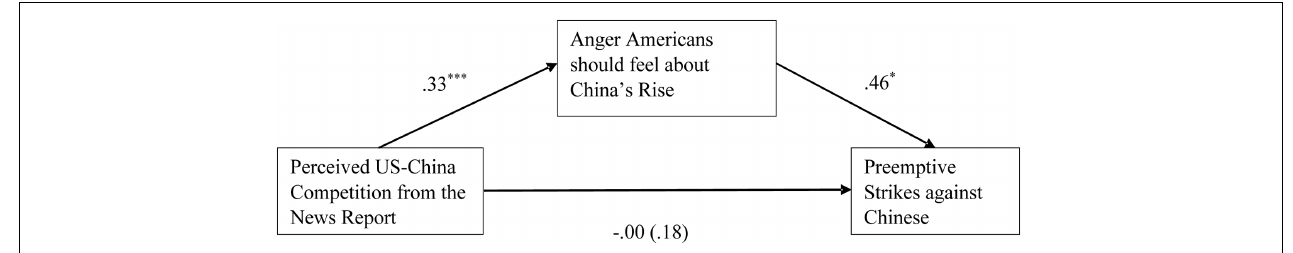
FIGURE 5 | Anger mediated the linkage from perceived United States–China competition to intergroup preemptive strikes against Chinese. Preemptive strikes against Japanese were controlled as a covariate. Preemptive strike was coded as 0 = No attack and 1 = Attack . The regression involving the binary PSG decision is logistic. For the path from the independent variable (perceived United States–China competition) to the outcome (preemptive strikes against Chinese), the regression coefficient in parentheses did not control for the mediator. All regression coefficients are unstandardized. ∗ p < 0.05; ∗∗∗ p <